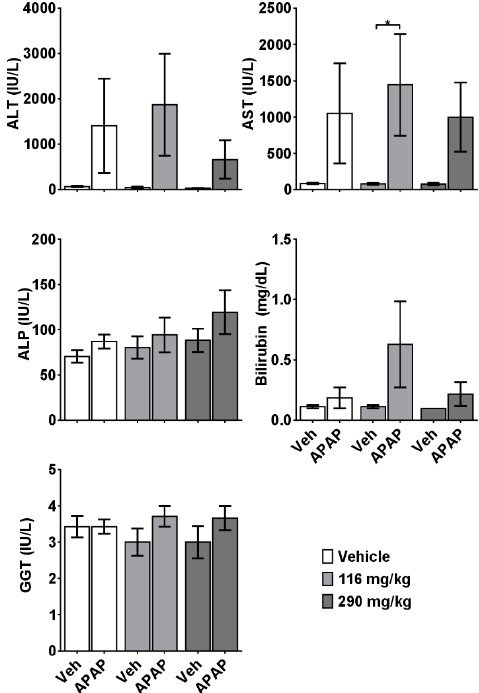
Figure 2. E ff ects of CRCE / APAP co-administration on commonly assessed clinical chemistry parameters for liver injury. Blood was collected at the time of sacrifice, and the serum was subsequently separated and removed for analysis. Veh ( n = 7); Veh + APAP ( n = 7); 116 mg / kg CBD ( n = 7); 116 mg / kg CBD + APAP ( n = 5); 290 mg / kg CBD ( n = 7); 290 mg / kg CBD + APAP ( n = 6). Data are presented as mean ± SEM (* p < 0.05). ALT: alanine aminotransferase; AST: aspartate aminotransferase; ALP: alkaline phosphatase; GGT: gamma-glutamyl